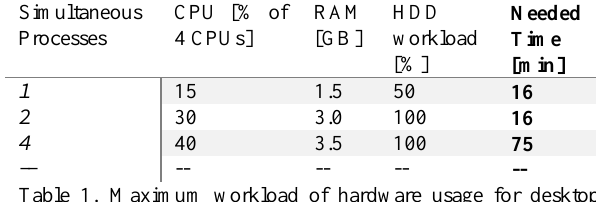
Table 1. Maximum workload of hardware usage for desktop